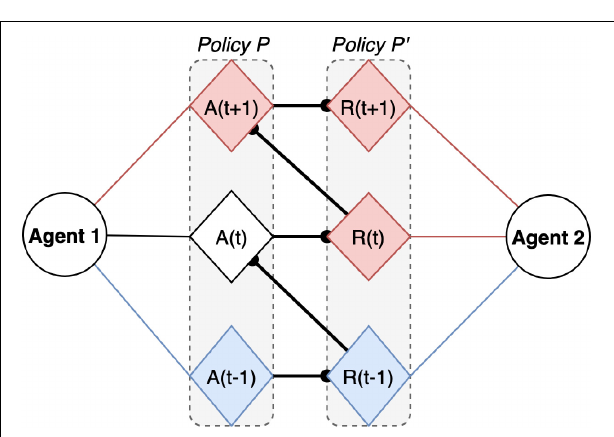
FIGURE 6 | A trust dyad, whereby Agent 1 performs action A at t, within the action policy P, and in collaboration with Agent 2. In a trustworthy relationship, Agent 1 can expect from Agent 2 an action Policy P’, where P’ is symmetrical to P (each action of P’ at t + 1 is a response to P at t). Past (observed) actions are blue and future (anticipated) actions are red. The bold line in between policies represents the shared policy (or joint narrative), whereby A(t + 1) can be prepared based on beliefs about anticipated